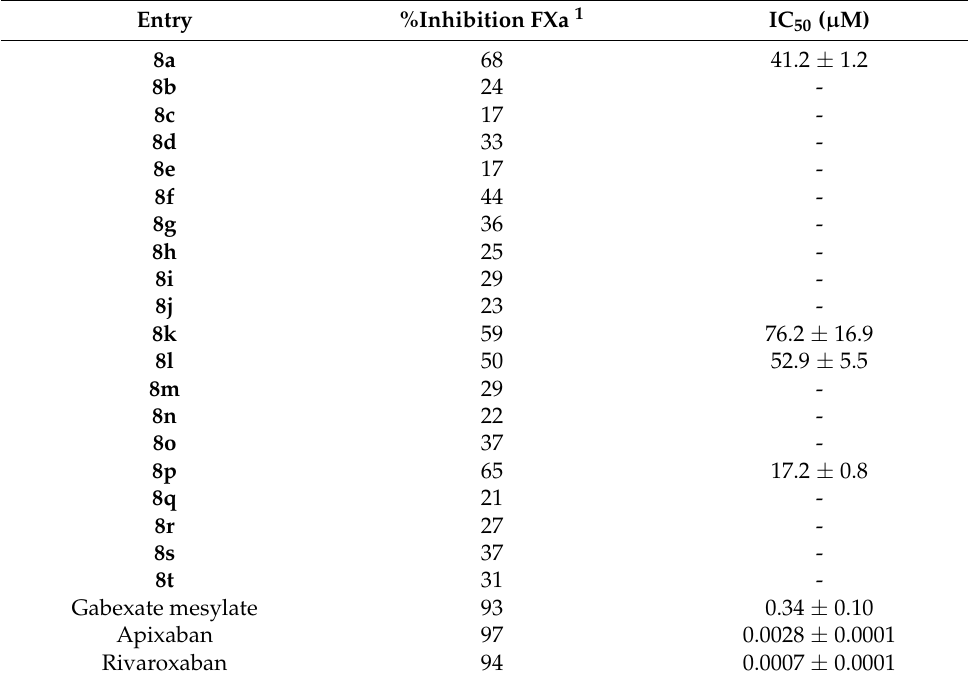
Table 2. FXa inhibition and IC 50 values of novel compounds 8a – t